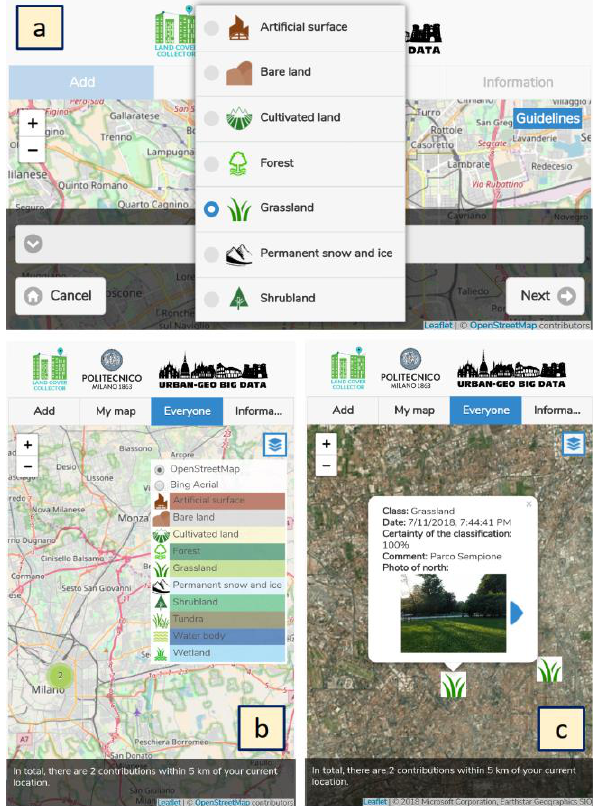
Figure 9. Screenshots of the Land Cover Collector application showing LC classification (a), visualization of data aggregated in clusters (b) and query of a collected point